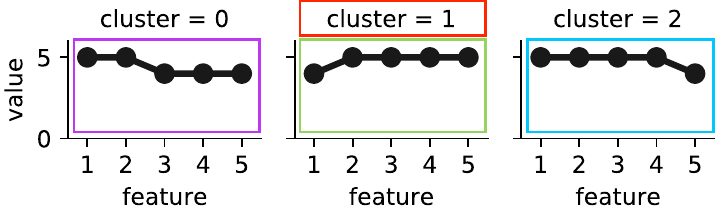
Figure 3. Building B_3’s substation’s operational behaviour in weeks 2 and 3 in 2017. Each cluster is shown by its exemplar. The colored frames represent the consensus clustering solution, where purple = cluster 0, green = cluster 1 and blue = cluster 2. The exemplars of clusters 0 and 2 are chosen from week 2, and cluster 1 is chosen from week 3. After building an MST on top of the consensus clustering solution, cluster 1 is identified as the deviating behaviour of the substation due to its small size and distance from the majority of the data.